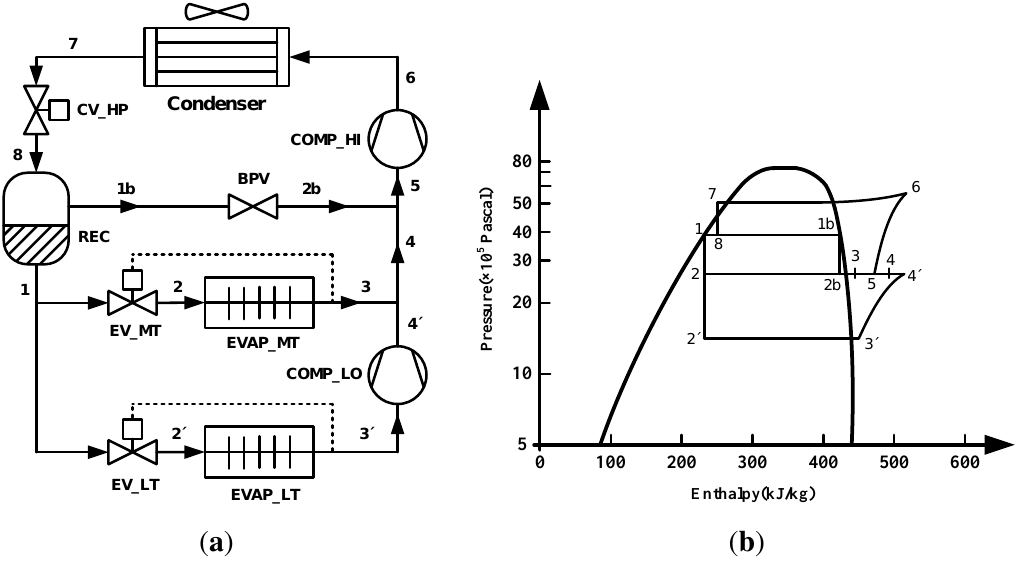
Figure 2. CO refrigeration systems ( a ) A typical booster configuration; ( b ) Corresponding 2 P-H diagram of subcritical cycle in the booster